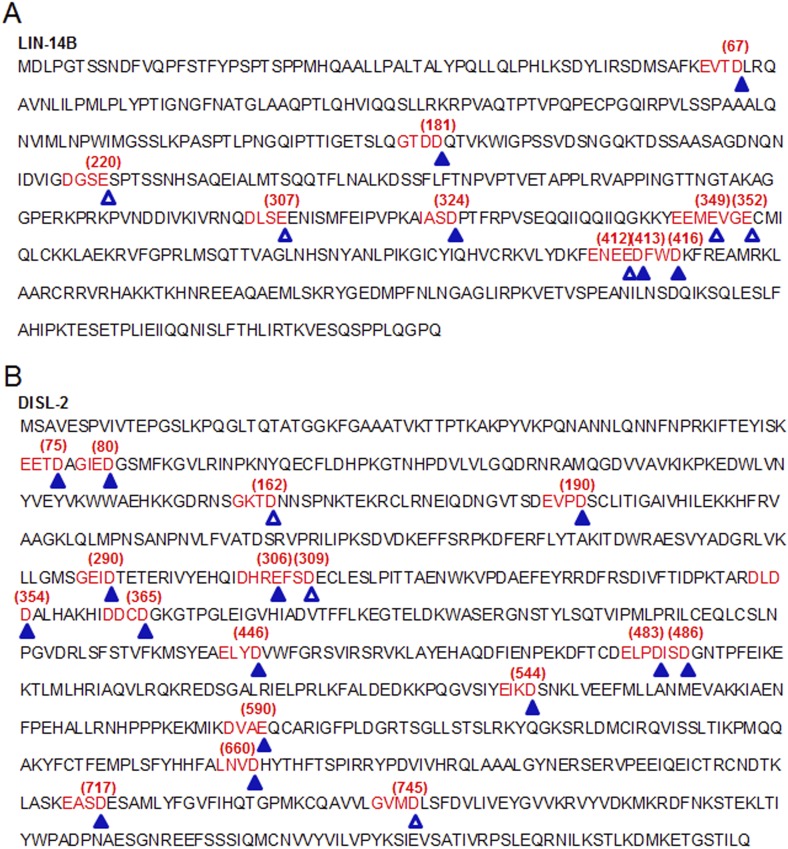
Identification of possible CED-3 cleavage sites in LIN-14 and DISL-2.Numerous possible CED-3 cleavage sites are found in LIN-14B and DISL-2 based on the consensus motif detailed in Figure 7—figure supplement 1 (Xue et al., 1996). (A–B) Potential CED-3 substrate tetrapeptides are shown in red font, some of which overlap. Closed triangles and open triangles indicate potential cleavage sites of high and moderate probability, respectively. The numbers in parentheses above the sequences indicate the proximal acidic residue. The LIN-14B isoform is shown in (A) since this is the isoform we cloned. However, all of the predicted cleavage sites shown here are also present in the LIN-14A isoform, which differs in the amino terminus prior to the first predicted site.